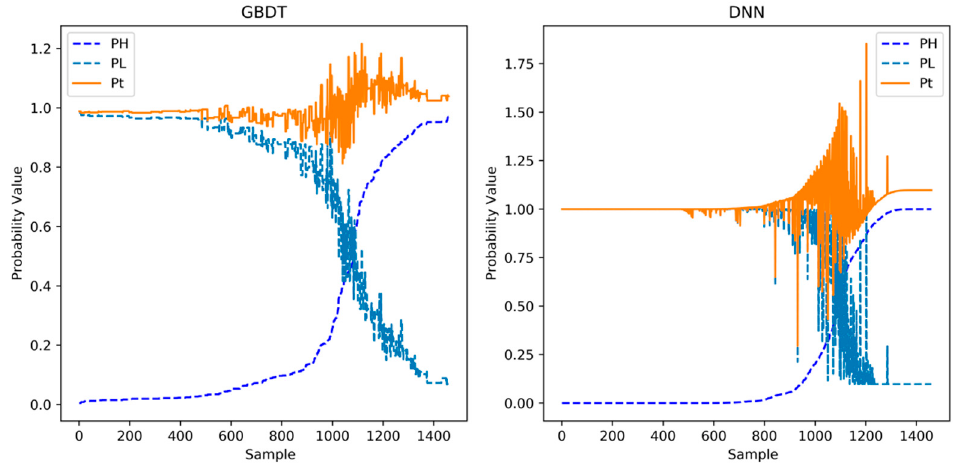
Figure 2. The distributions of three probabilities generated from the first stage.